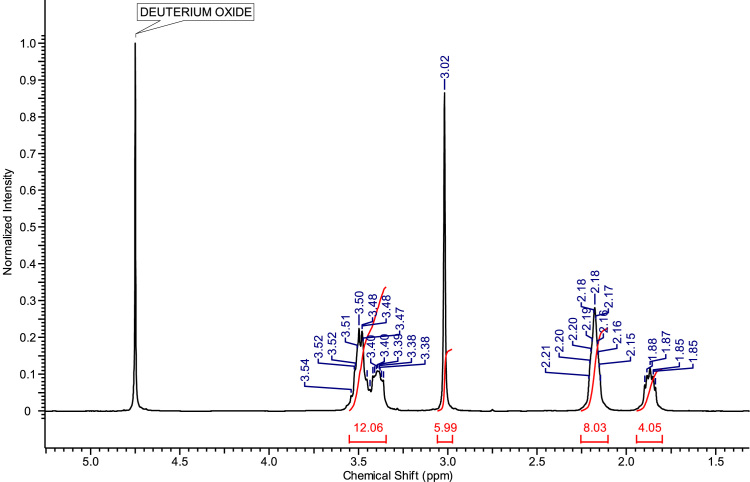
1H NMR spectra of C4(MPyrr)2Br2.